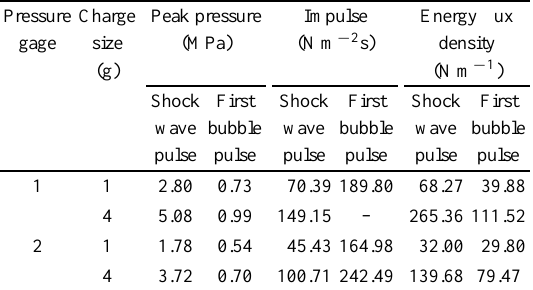
Comparison between shock wave and bubble pulse characteristics for detonator type 79 Pressure Charge Peak pressure